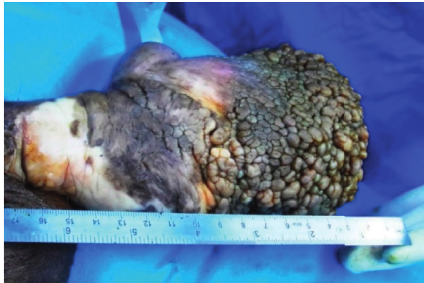
Figure 1: Giant fibroepithelial mass measuring at 13cm on the ventral aspect of the shaft and glans penis.